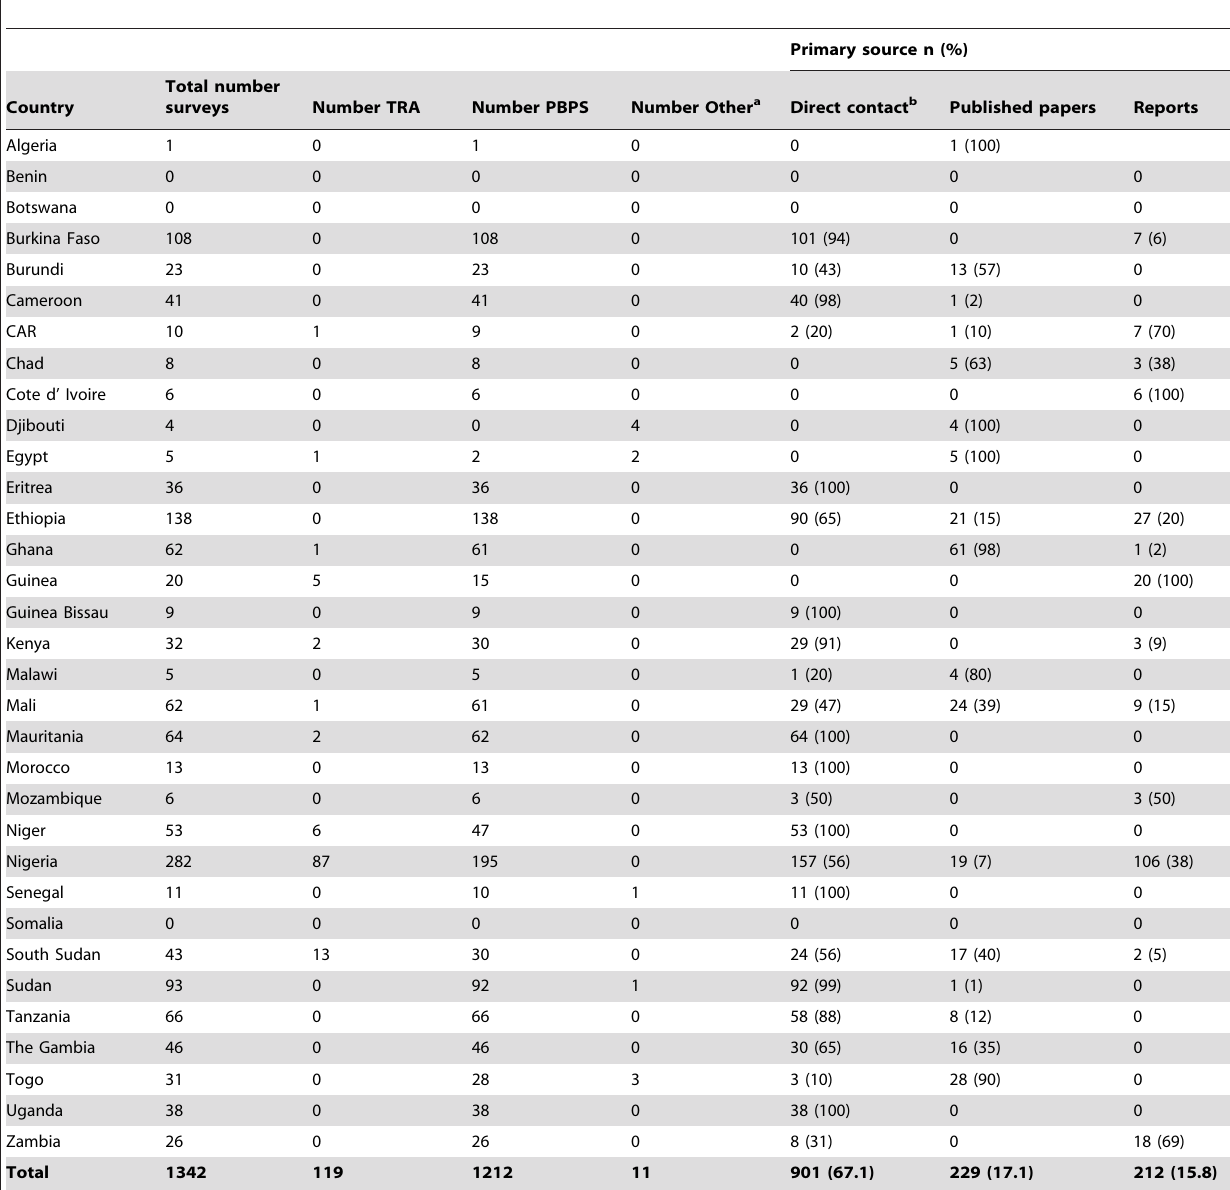
Table 2. Total number of district-level population based prevalence surveys (PBPS),trachoma rapid assessments (TRA) and site- specific surveys in database from countries in Africa, summarised by source of